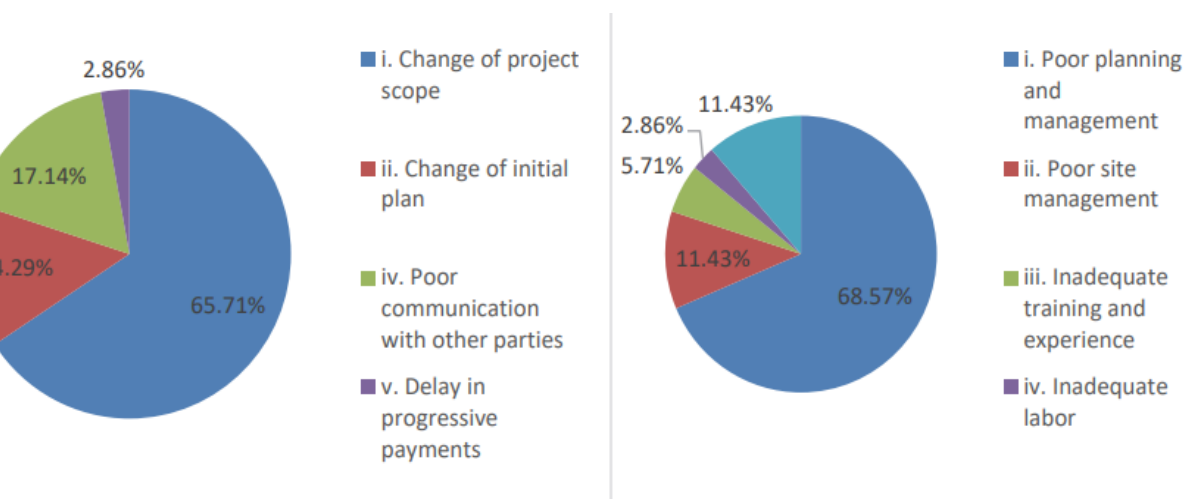
Table 2. The magnitude of building project delays as reported by earlier studies [27]. Reference Country